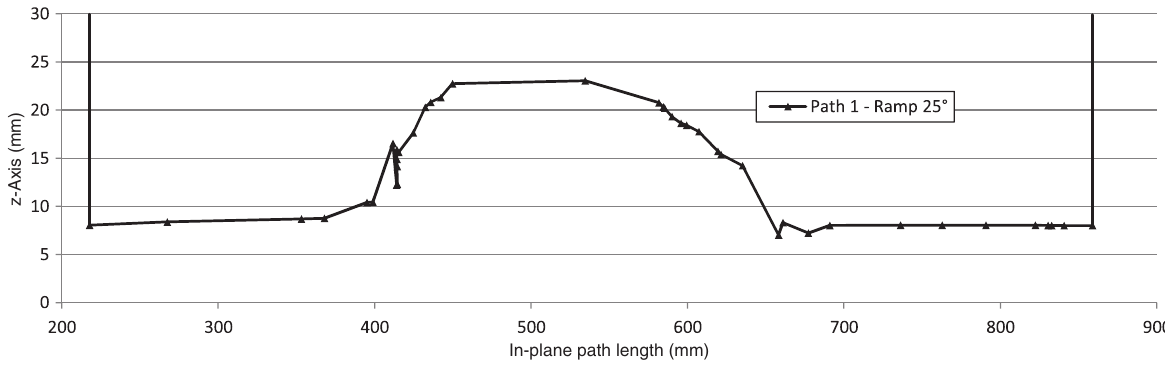
Figure 33 Generated path points: z -axis over in-plane path length.